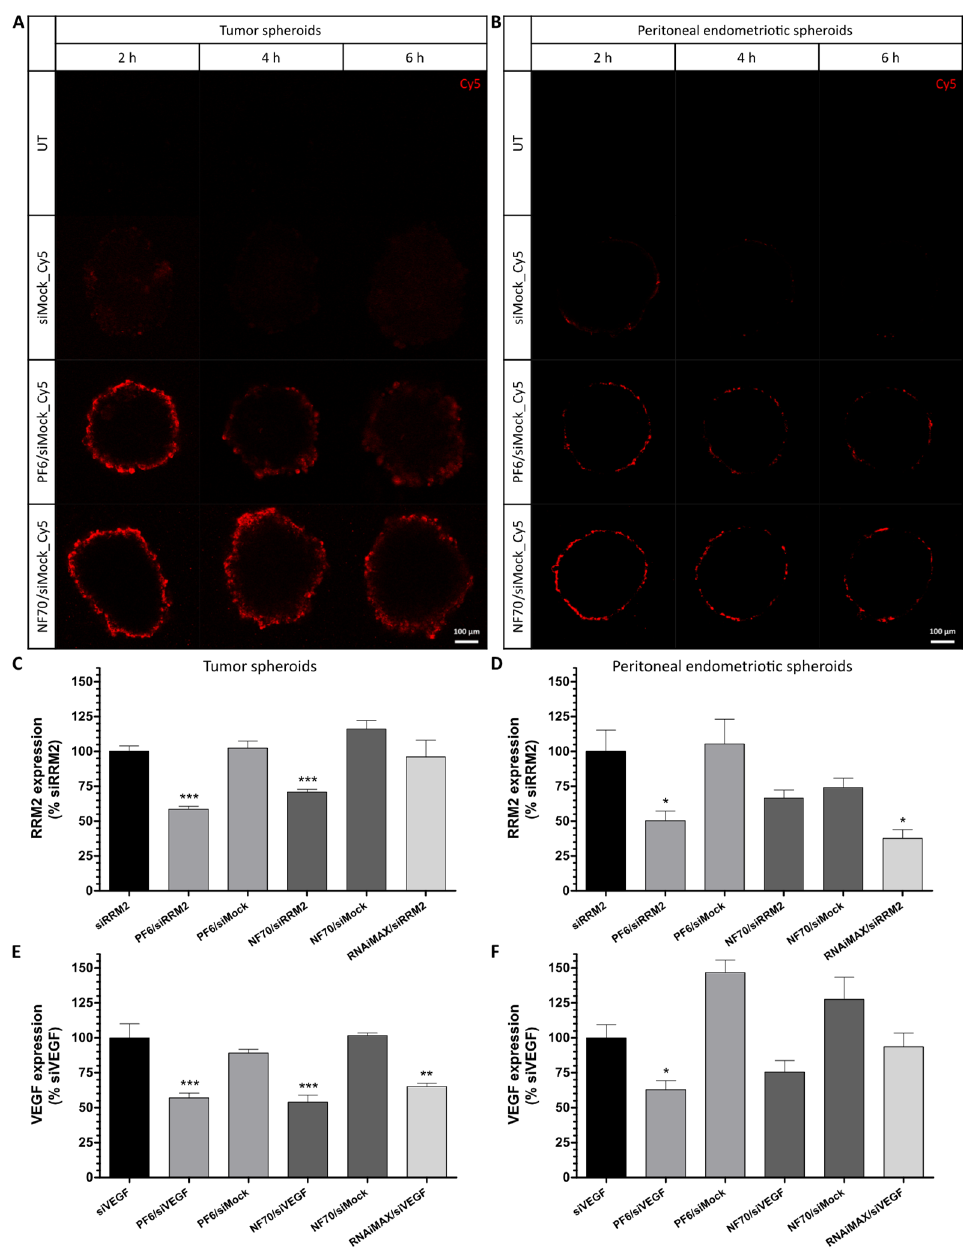
Figure 4. CPP/siRNA NPs exhibited efficient tissue penetration properties and induced therapeutic gene knockdown in 3D spheroid models. ( A , B ) Representative confocal images of CPP and fluores- cently labelled siMock (red) nanoparticle accumulation into ( A ) U-87MG tumor and ( B ) peritoneal endometriotic spheroids, n = 3 independent experiments. Scale bar: 100 µm. ( C , D ) RRM2 and ( E , F ) VEGF gene expression levels measured in ( C , E ) U-87MG and ( D , F ) peritoneal endometriotic spheroids using qRT-PCR 48 h after transfection. Data were analyzed by 2 − ∆∆ CT method using GAPDH as an internal control and normalized to relevant pure siRNA groups. Error bars represent SEM of n = 7–9 individual samples from independent experiments. * p < 0.05, ** p < 0.01, *** p < 0.001, one-way ANOVA, Tukey post hoc. UT,